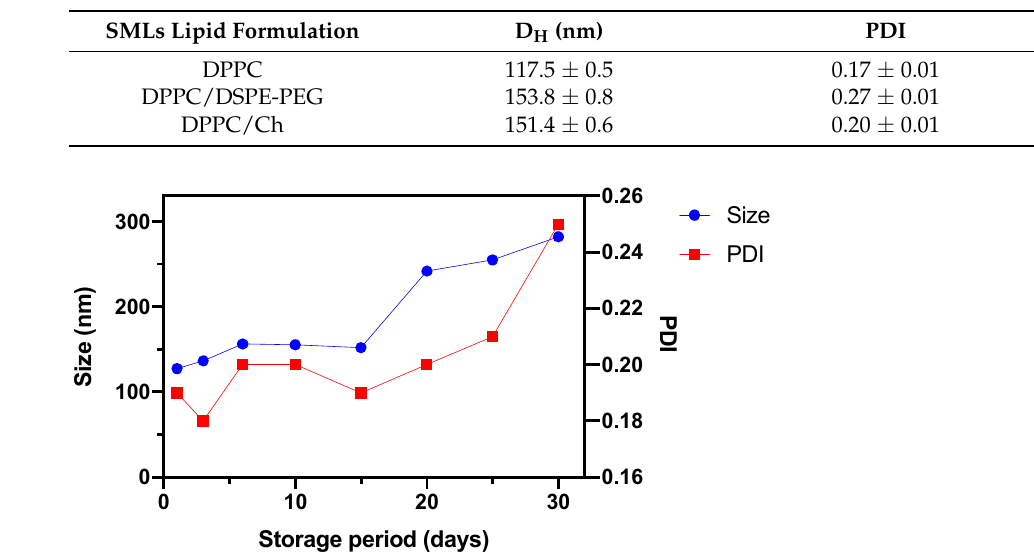
Table 3. Hydrodynamic diameter (D H ) and polydispersity (PDI) at 25 ◦ C. Results as mean ± SD.